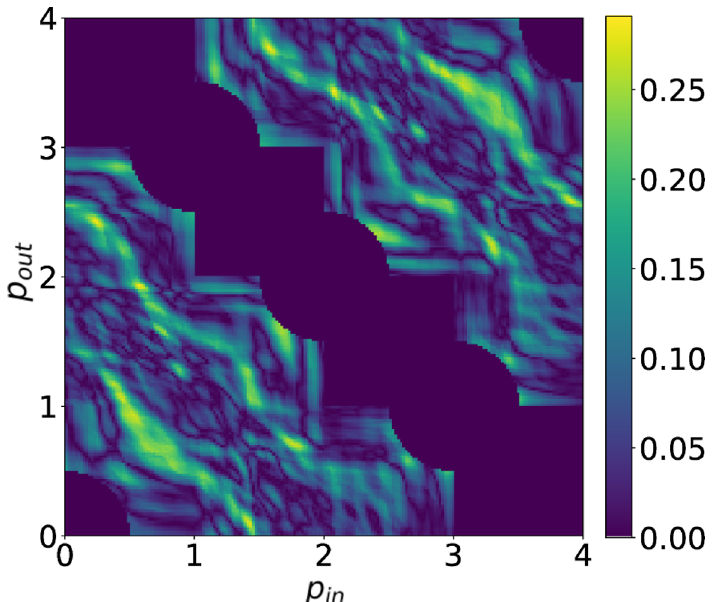
Figure 25 . The same as figure 22 but for the dataset with a circular boundary shown in the right panel of figure 24.